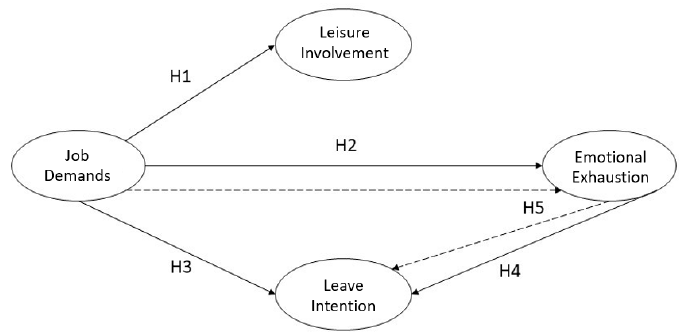
Figure 1. The research structure diagram.